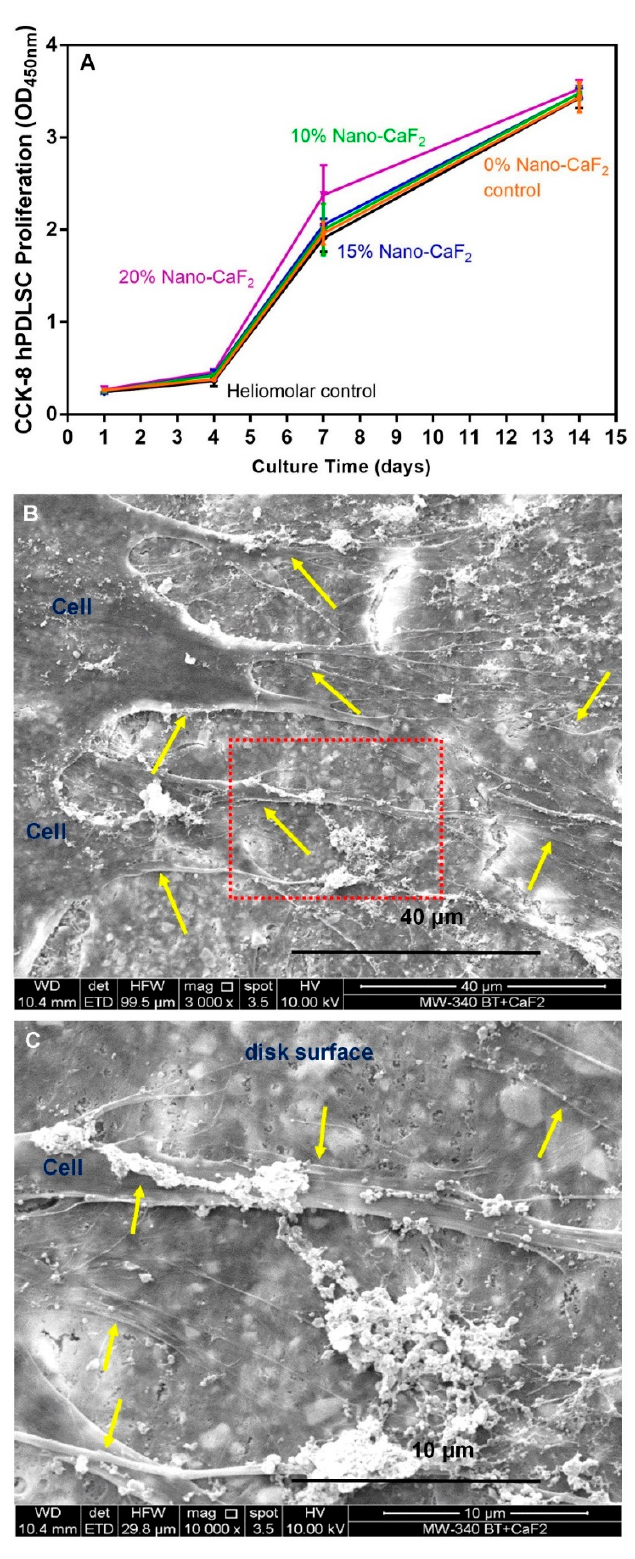
Figure 3. Proliferation and SEM images of hPDLSCs attaching to the composites. ( A )The cell proliferation was not adversely affected by the addition of Nano-CaF 2. The number of cells increased by approximately 12 folds from 1 to 14 days ( p > 0.1, mean ± SD; n = 6). ( B , C ) The representative SEM images of hPDLSCs seeding on the surface of composite disks at 14 days. The hPDLSCs formed long cytoplasmic extensions (yellow arrows) that adhered to the surface of composite. Therefore, the composites were biocompatible and promoted hPDLSC adherence (n = 6).